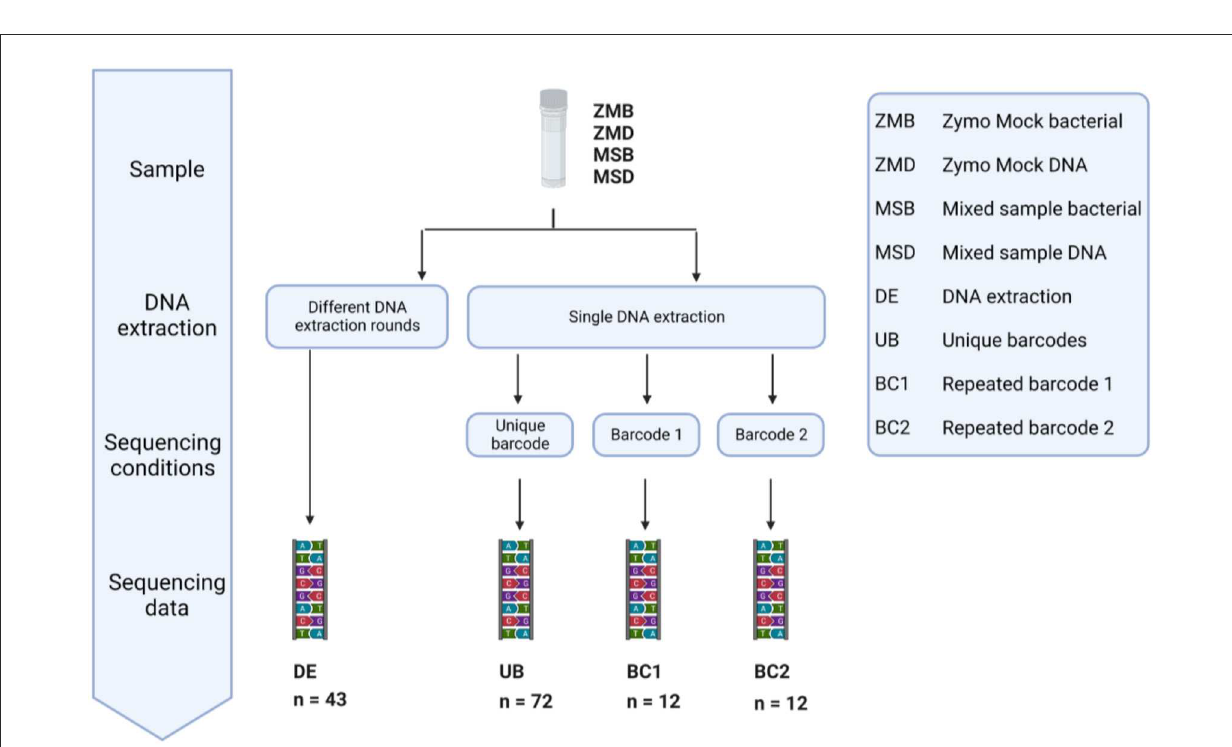
FIGURE12 Overview of the conditions tested to measure the variation in large microbiome studies introduced during different DNA extraction rounds, multiple sequencing runs, and the use of barcodes as a unique identifier. DNA of 20 Zymo mock community samples and 23 mixed samples was extracted in different DNA extraction (DE) rounds. The effect of sequencing with a different barcode was tested by repeated sequencing of Zymo mock DNA and Mixed sample DNA 36 times using a different Illumina barcode (UB). The same DNA samples (ZMD and MSD) were sequenced six times using the same Illumina barcode (BC1 and